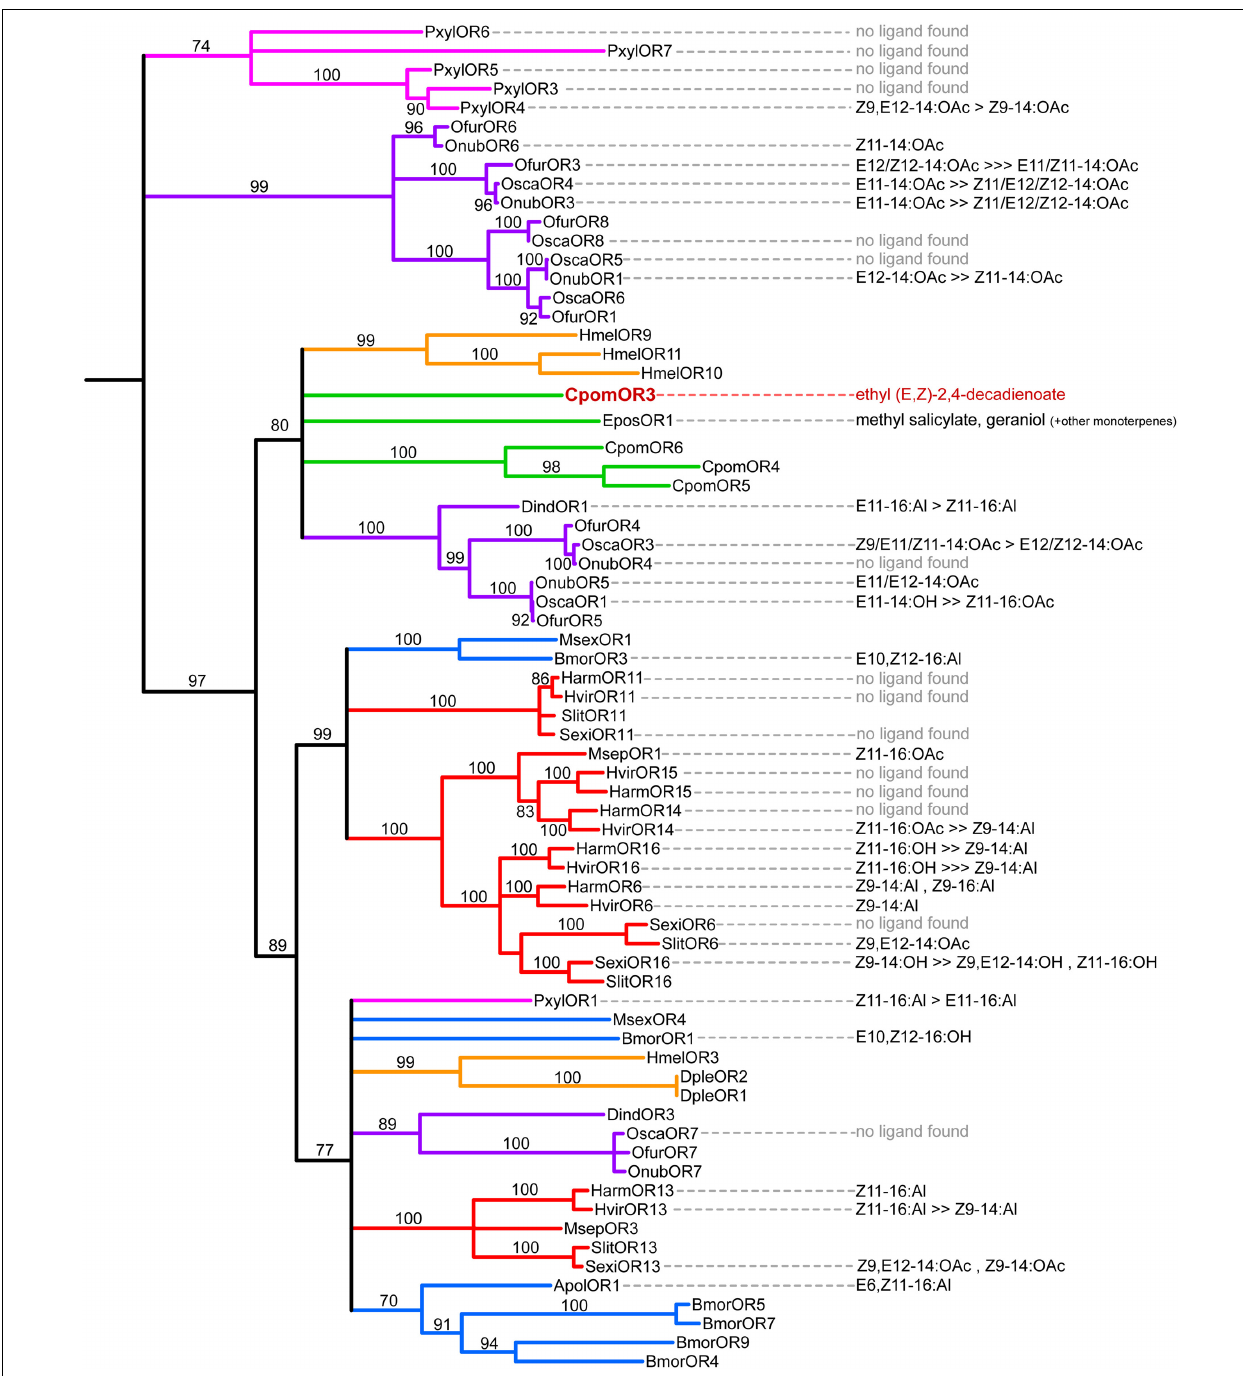
FIGURE 1 | Maximum likelihood tree of lepidopteran candidate PRs, highlighting their corresponding ligand(s). Branch colors represent different lepidopteran lineages: blue for Bombycoidea, red for Noctuoidea, orange for Papilionoidea, purple for Pyraloidea, green for Tortricoidea, and pink for Yponomeutoidea. The outgroup (containing BmorOR6 and HmelOR5, 6, and 7) has been removed from the figure. Functional data has been compiled from the literature (see references in the Methods section). “No